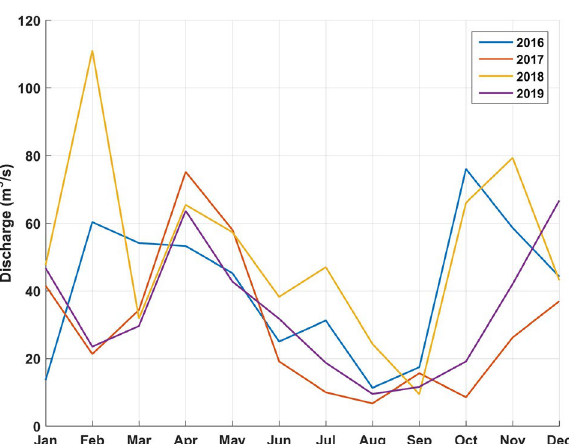
Figure 5. Bay du Nord river monthly averages discharge for years 2016–2019 as reported by Environment and Climate Change Canada 21 .